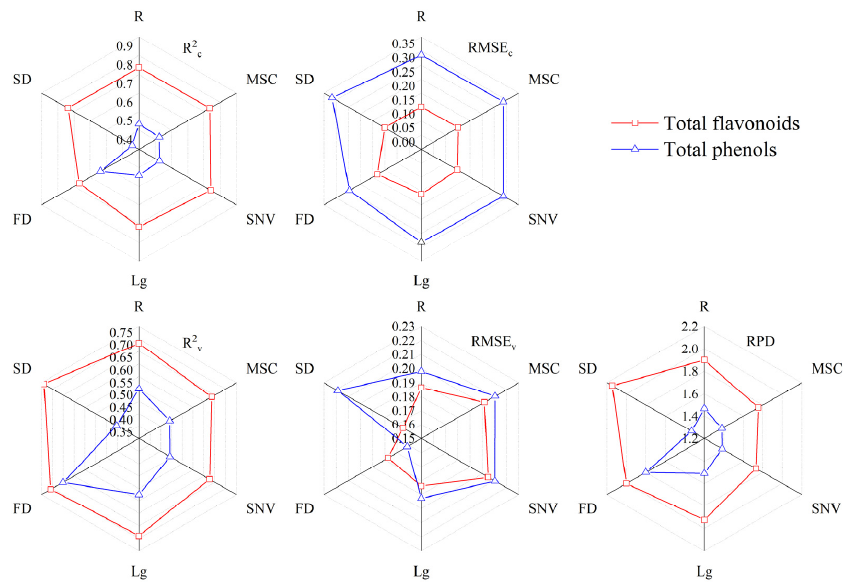
Figure 3. PLSR monitoring model of total fl avonoids and total phenols in grains.